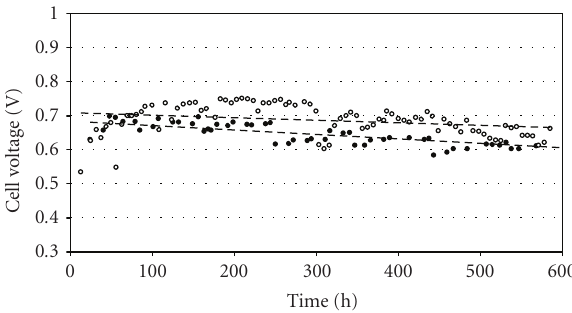
Figure 1: Cell voltage versus time plot for MEA with Nafion 112 ( • ) and Nafion/MMT E87-05 ( ◦ ) at 250 mAcm − 2 .